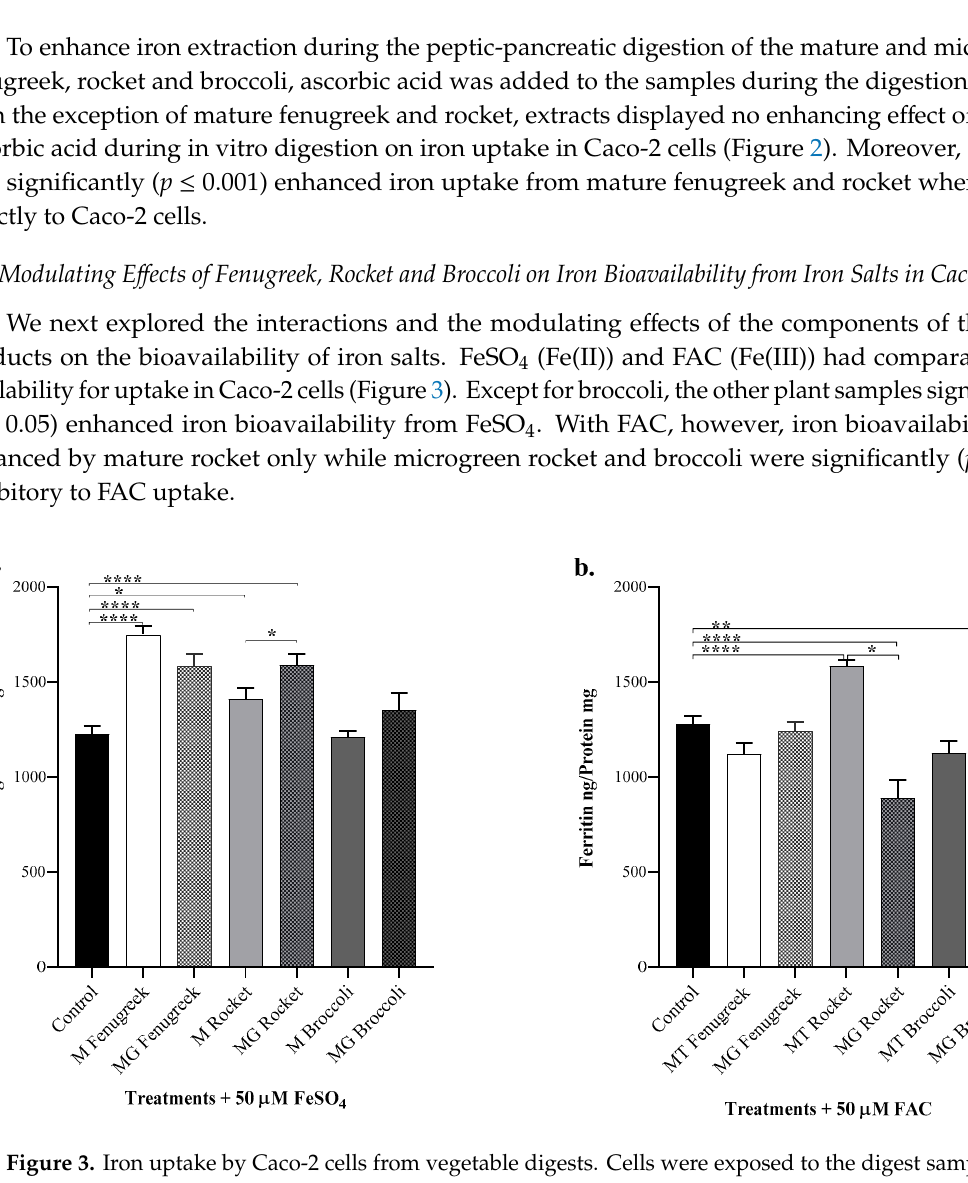
Figure 3. Iron uptake by Caco-2 cells from vegetable digests. Cells were exposed to the digest samples with added 50 μ M: ( a ) FeSO 4 (Fe(II)); and ( b ) FAC (Fe(III)). Results are presented as means of ± SEM n = 6. Data were analysed using a two-way ANOVA test between control and vegetable samples or among mature and microgreen samples. The differences between groups are denoted: *( p ≤ 0.05), **( p ≤ 0.01) and ****( p ≤ 0.0001).